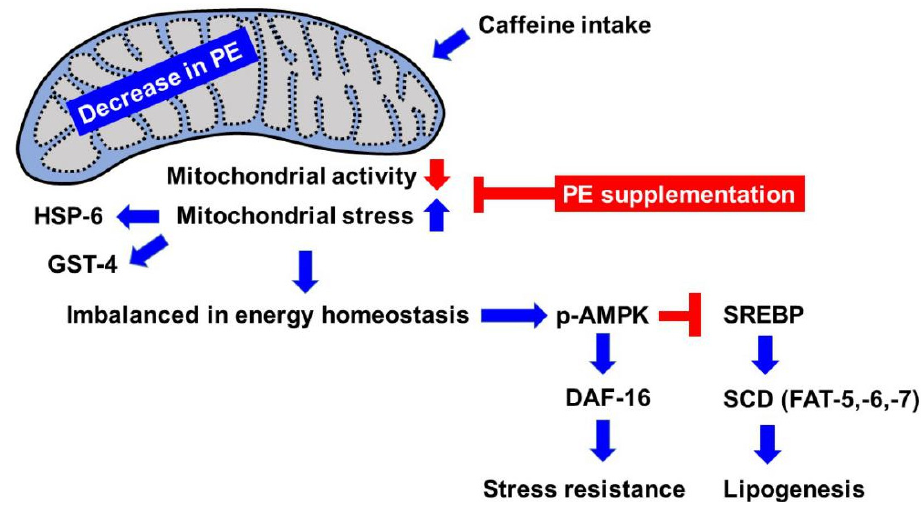
Figure 8. Model of the beneficial effects of phosphoethanolamine (PE) supplementation on mitochondrial stress and lipogenesis owing to caffeine intake in Caenorhabditis elegans